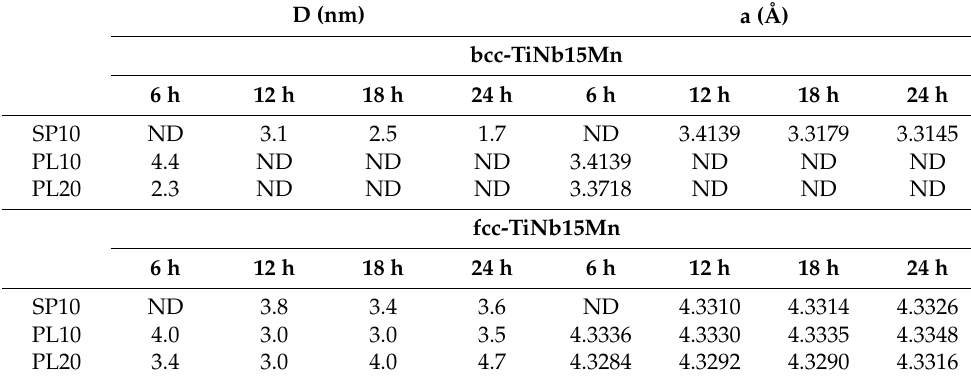
Table 1. Crystalline domain size (D) and lattice parameters (a = b = c) for both bcc-TiNb15Mn